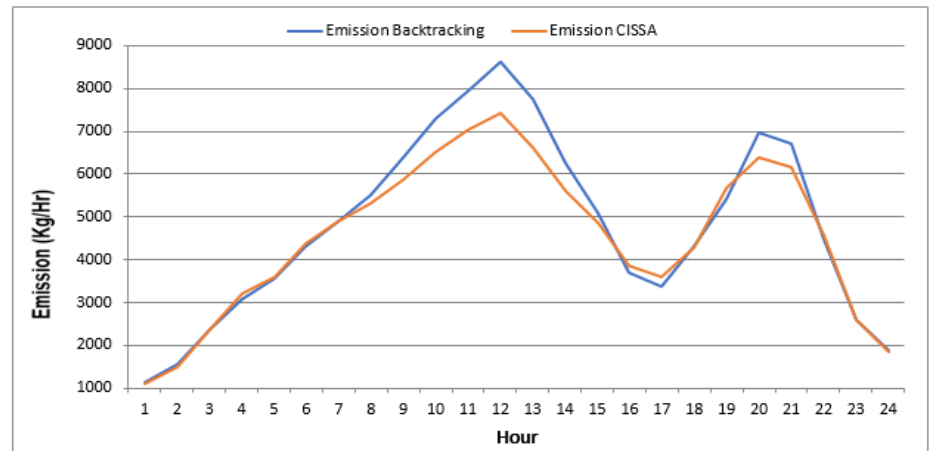
Figure 15. Emissions comparison between CISSA and back-tracking. Table 31. Total daily emissions comparison — case study 3.